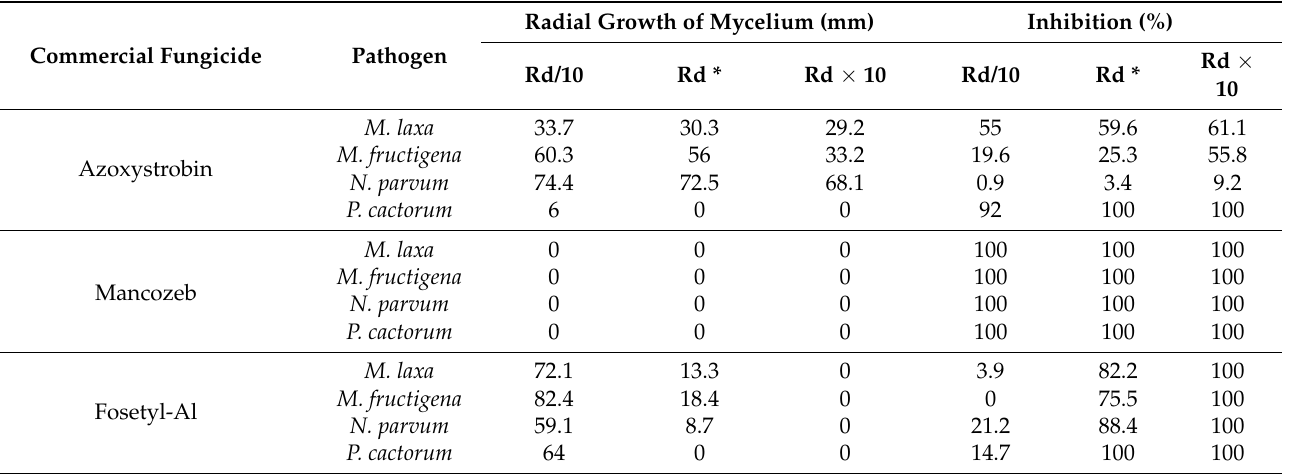
Table 3. Radial growth of mycelium of M. laxa , M. fructigena , N. parvum, and P. cactorum in in vitro assays performed on a PDA medium with different concentrations (the recommended dose, a tenth of the recommended dose, and ten times the recommended dose) of three commercial synthetic fungicides.